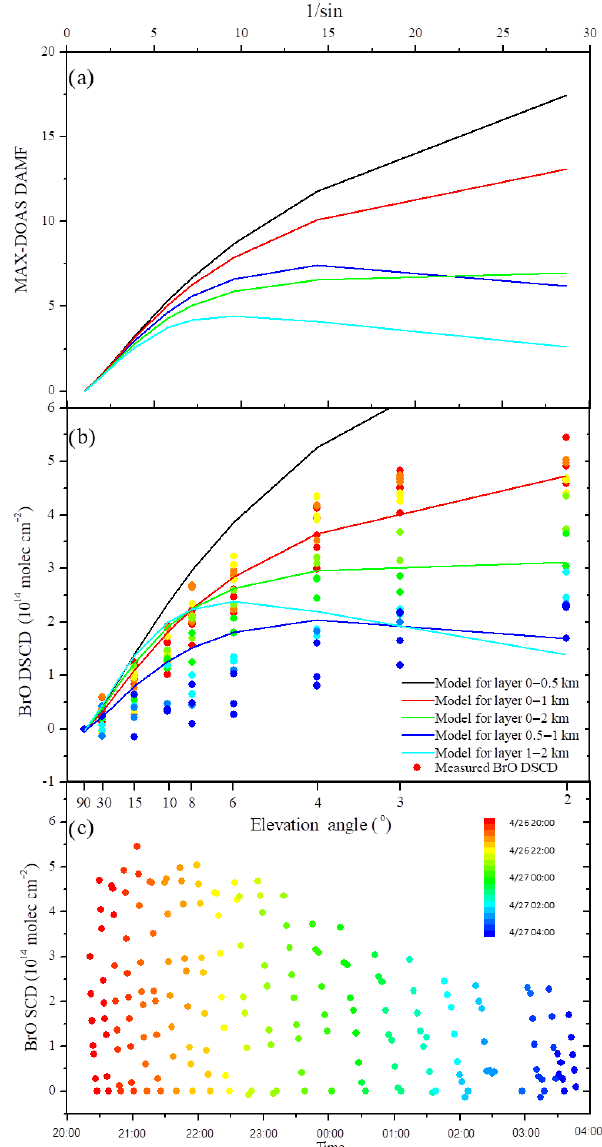
Figure 5. Modeled DAMF (a) and BrO DSCD (b) using a radia- tive transfer modeling simulation. DAMF are the differences of air mass factor for low elevation angles and zenith direction. The mod- els are performed assuming clear sky conditions with no aerosol. In (b) , the tropospheric BrO VCD is 5 × 10 13 moleccm − 2 . The mea- sured BrO DSCDs during the event are also shown (solid dots). The color codes of the measured BrO DSCDs, which are also shown in (b) (solid dots), are put into a one-to-one correspondence with the dots in (c)